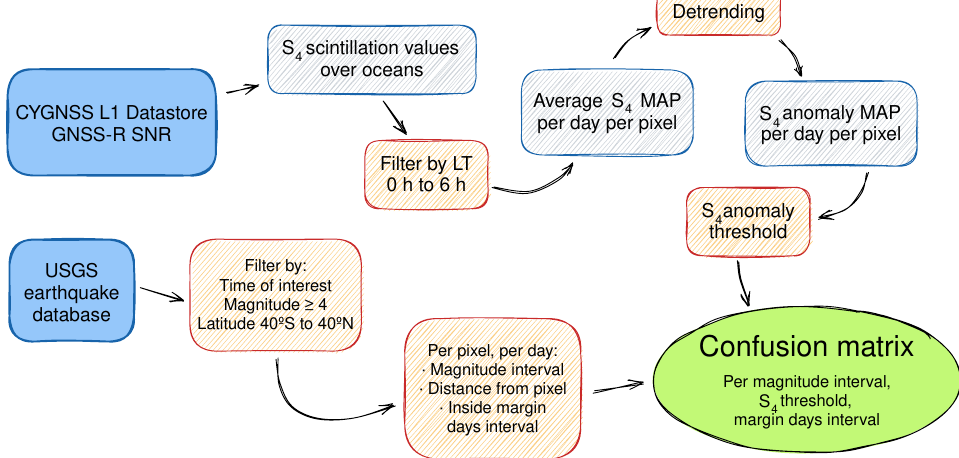
Figure 6. Diagram showing the complete data processing, from raw data sources to the CM inputs.